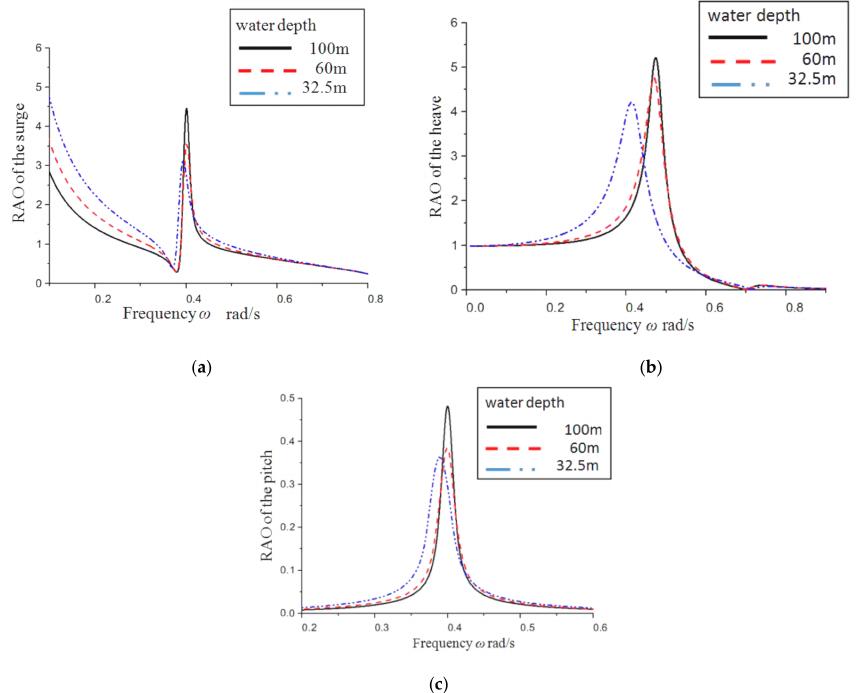
Figure 8. RAO of the platform with air cushion in di ff erent water depths. ( a ) Surge RAO; ( b ) heave RAO; ( c ) pitch